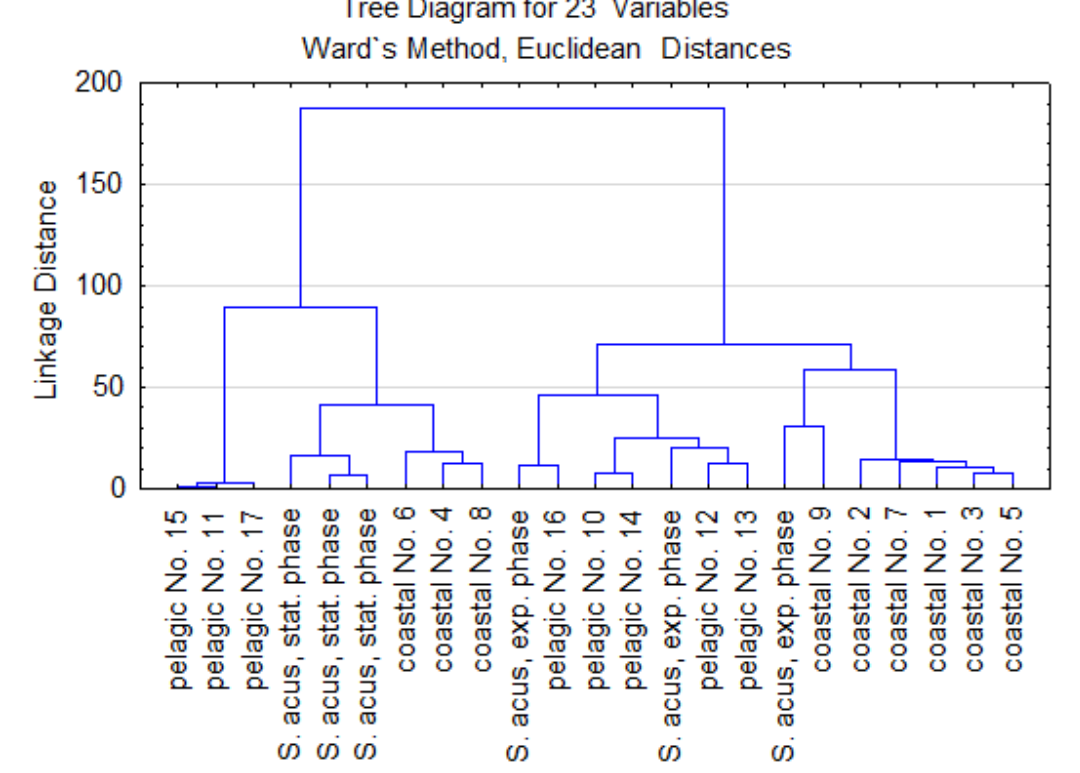
Figure 4. Dendrogram of the FA composition of the Baikal coastal and pelagic phytoplankton and the FA composition of the S. acus laboratory culture at stationary and exponential phases of growth.